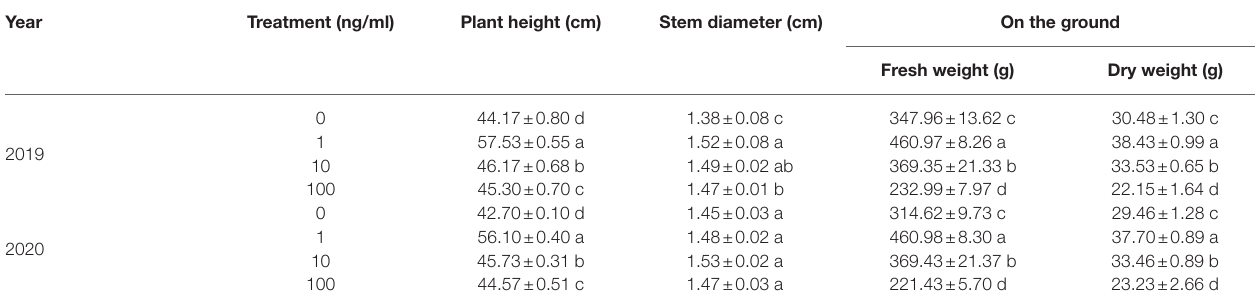
TABLE 1 | The potato growth influenced by different concentrations of ZNC through irrigation in the field. a